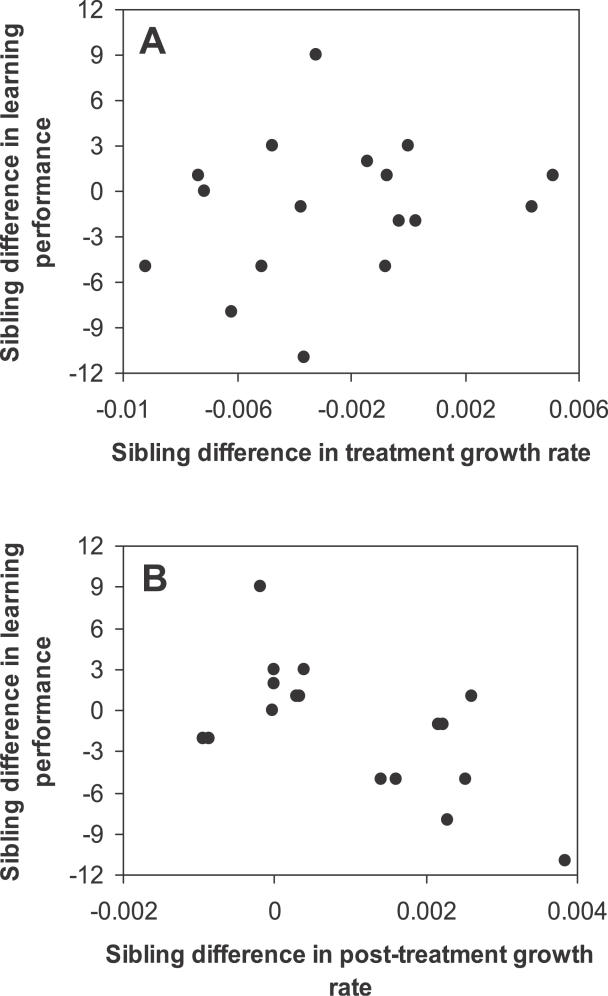
Relationship between Compensatory Growth following a Period of Low-Quality Early Nutrition and Associative Learning Performance in AdulthoodWithin-sibling differences (D sib – N sib) in the growth increment from (A) day 0 to 20 and (B) day 20 to 70 and learning performance are plotted so that each data point represents a sibling pair. Positive values for growth indicate that the D sib grew faster during the postdeficit period than its same-sex N sib that had experienced normal nutrition throughout growth. The learning performance was scored on the basis of the number of trials it took them to achieve two trials without error. Birds that did not reach this criterion obtained a score of zero and the fastest learners obtained the highest score. The figure shows the difference in score between the sibling pairs, and negative values mean that the D sib had a poorer learning performance than its N sib. There was no correlation between the intersib difference in growth during the deficit period (0 to 20 d) and learning performance in adulthood (A:
r
15 = 0.10,
p = 0.70); however, the faster the D sib grew relative to its N sib when normal nutrition was restored, the poorer was its learning performance in adulthood (B:
r
15 = 0.63,
p = 0.007). In this relationship, no point had a large influence (Cook's distance for all points <0.4).